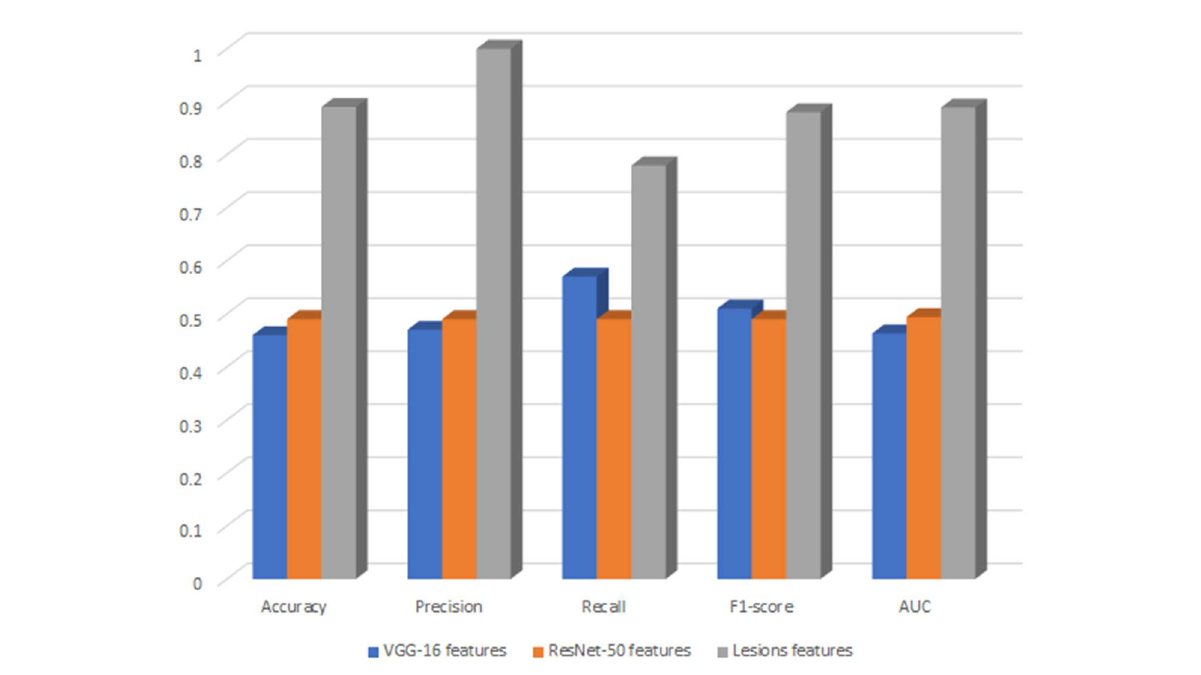
FIGURE2 The performance of XGBoost with VGG-16, ResNet-50 and lesions